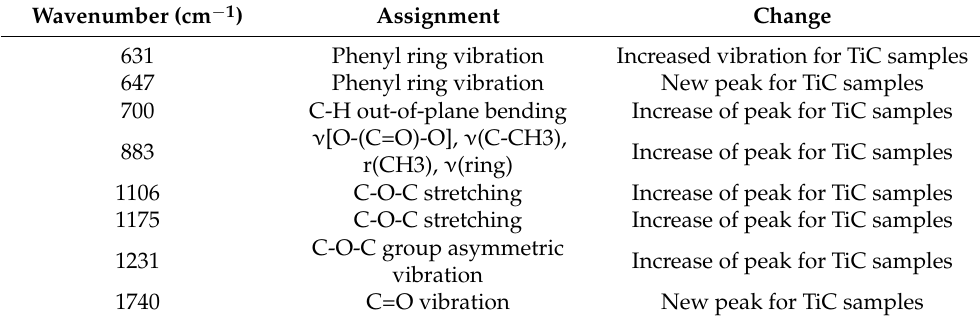
Table 4. The Raman spectra behavioral differences between the clear PC and the TiC